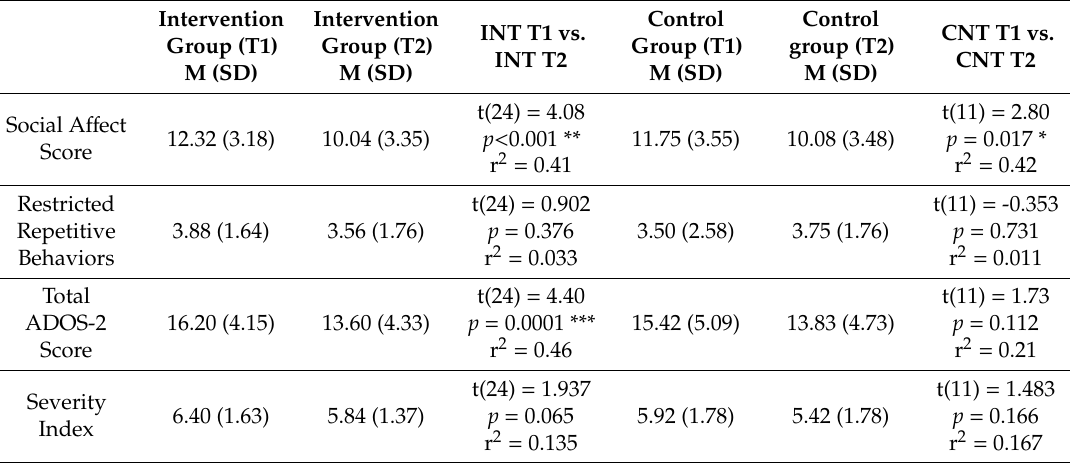
Table 3. ADOS scores in the two groups at T1 and